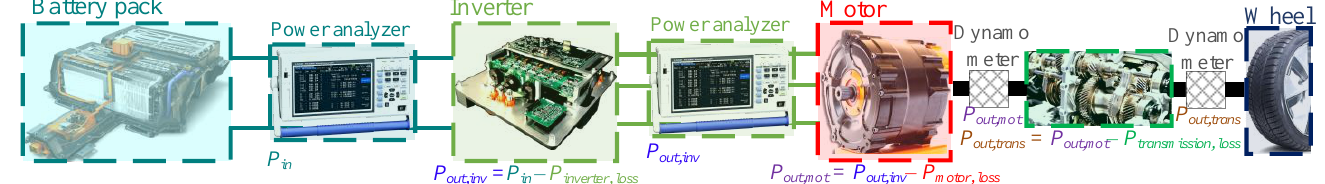
Figure 13. The placement of power analyzers and dynamo meters to measure each loss component of the EV propulsion system.